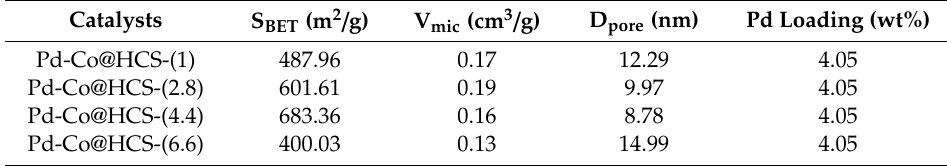
Figure 6. N 2 adsorption–desorption of Pd@HCS-(X). ( a ) Isotherm adsorption line; ( b ) pore size distribution. Table 2. Textural properties and Pd loading of Table 2. Textural properties and Pd loading of Pd-Co@HCS-(X).